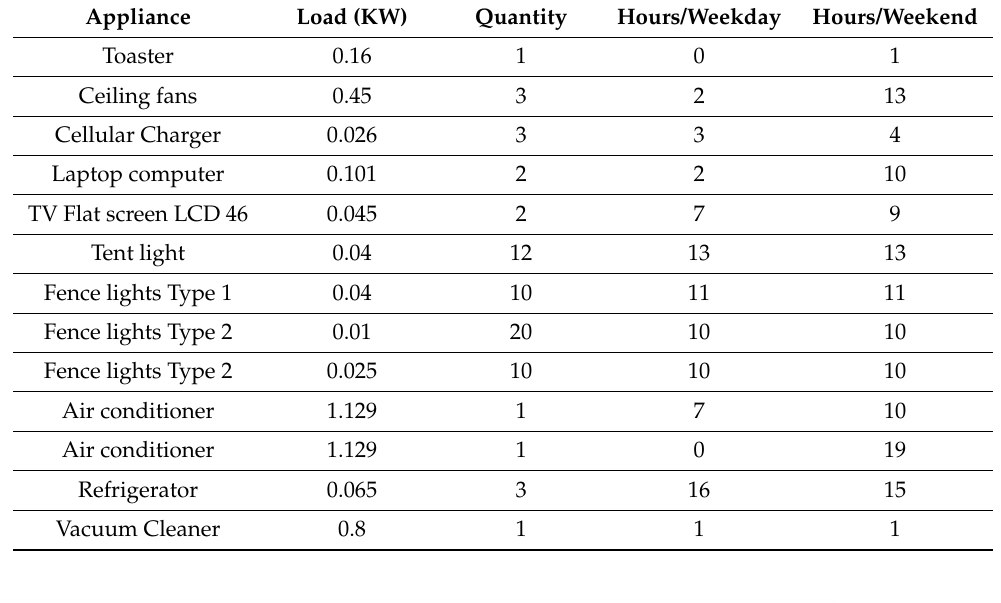
Figure 4. Solar irradiation per hour for Hafr Al-Batin city [48]. Table 1. Daily load demand details for a remote desert camp in Hafr al-Batin.